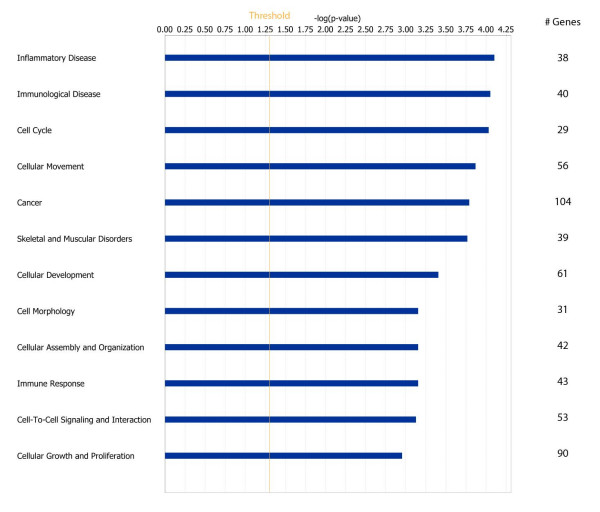
Significantly enriched biological categories. Chart of the most significantly enriched biological categories as identified with Ingenuity. For each category -log(p value) and number of genes are reported.